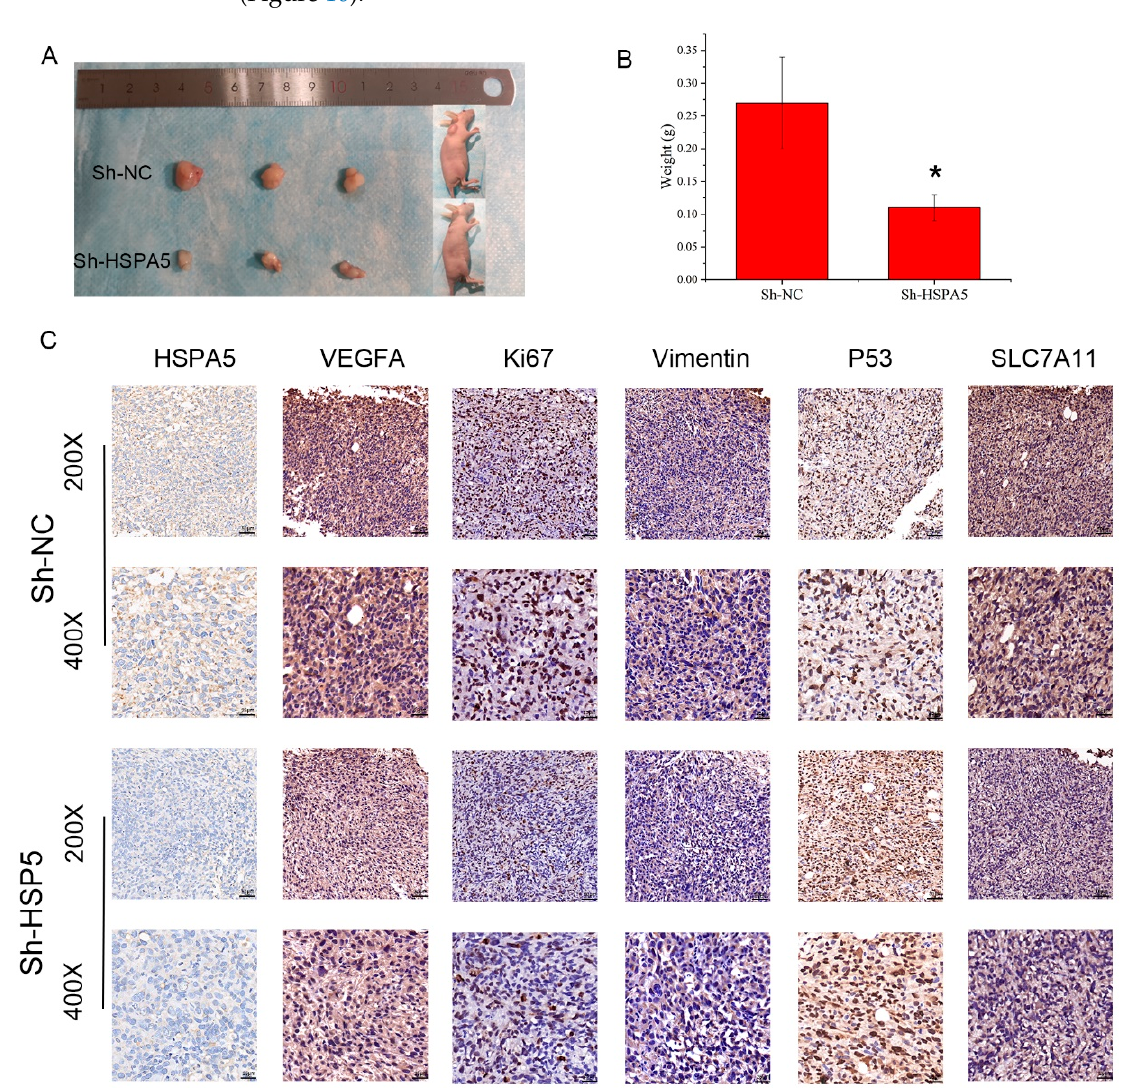
Figure 9. HSPA5 knockdown inhibits xenograft growth in vivo. ( A ) HSPA5 downregulation inhibited the growth rate of xenografts in vivo. ( B ) The tumors weights in the sh-HSPA5 groups were lower than those in the control group. ( C ) IHC results showing the expression of various proteins in tumors (200 × scale bar is 50 µ m and 400 × is 25 µ m). All data are presented as the mean ± SD. * p < 0.05.